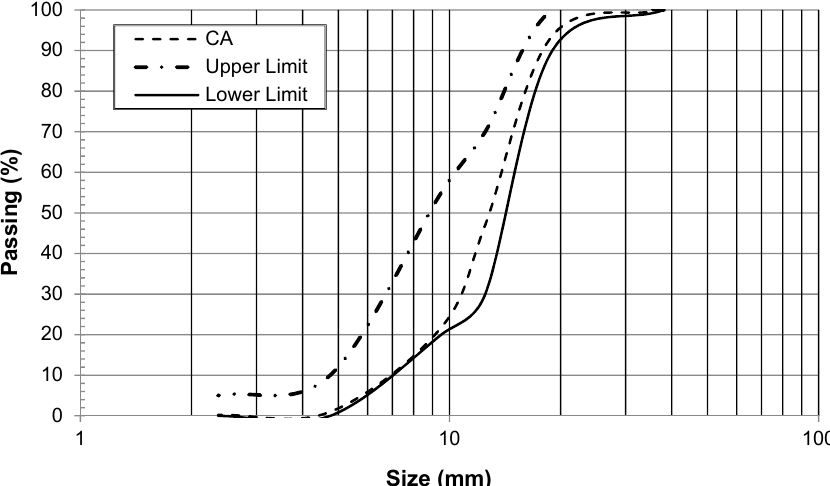
Figure 2. Gradation of coarse aggregate.